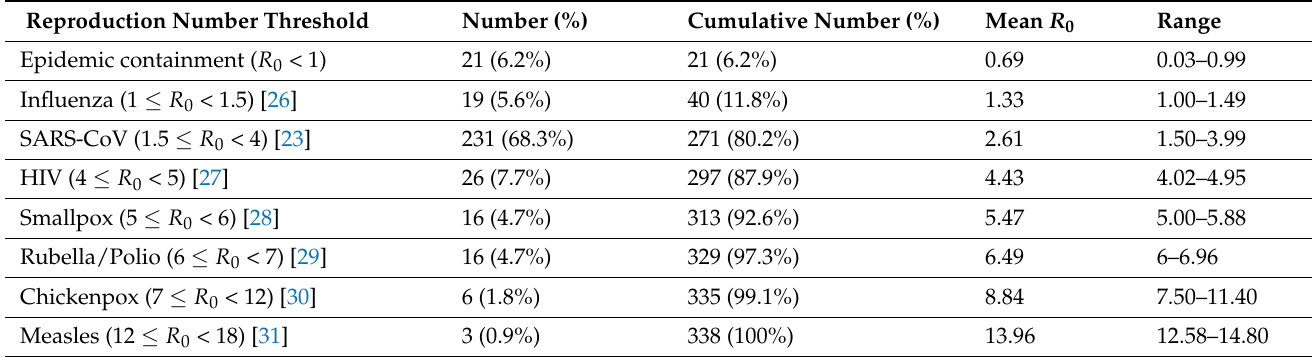
Table 2. Basic reproduction number ( R 0 ) of various infectious diseases with proportion of studies reporting R 0 within the given